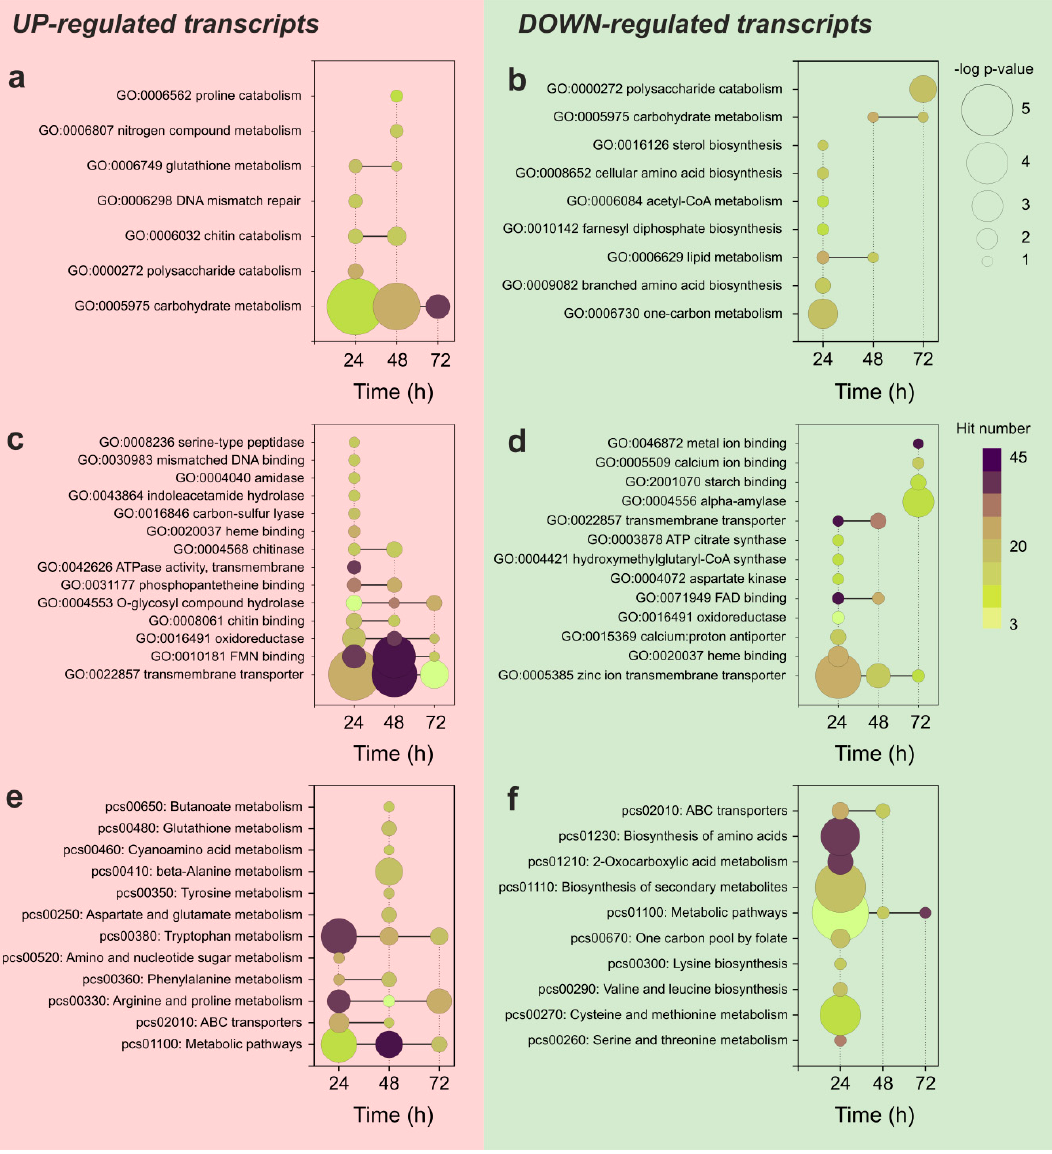
Figure 4. Functional analysis by gene set enrichment of the differentially expressed mRNA transcripts detected in cultures of P. chrysogenum var. halophenolicum containing APAP, performed by DAVID platform [43]. The left-hand side of the graph illustrates the enrichment analysis for the upregulated gene transcripts and the right-hand side is the analysis of the downregulated mRNAs. The size of the circular symbols depicting every functional category is proportional to the -log(p- value). The fill color of the symbols represents the number of functional hits detected within each category. ( a , b ) GO term enrichment analysis, biological process category; ( c , d ) GO term enrichment analysis, molecular function category; and ( e , f ) Pathway enrichment analysis, KEGG database.